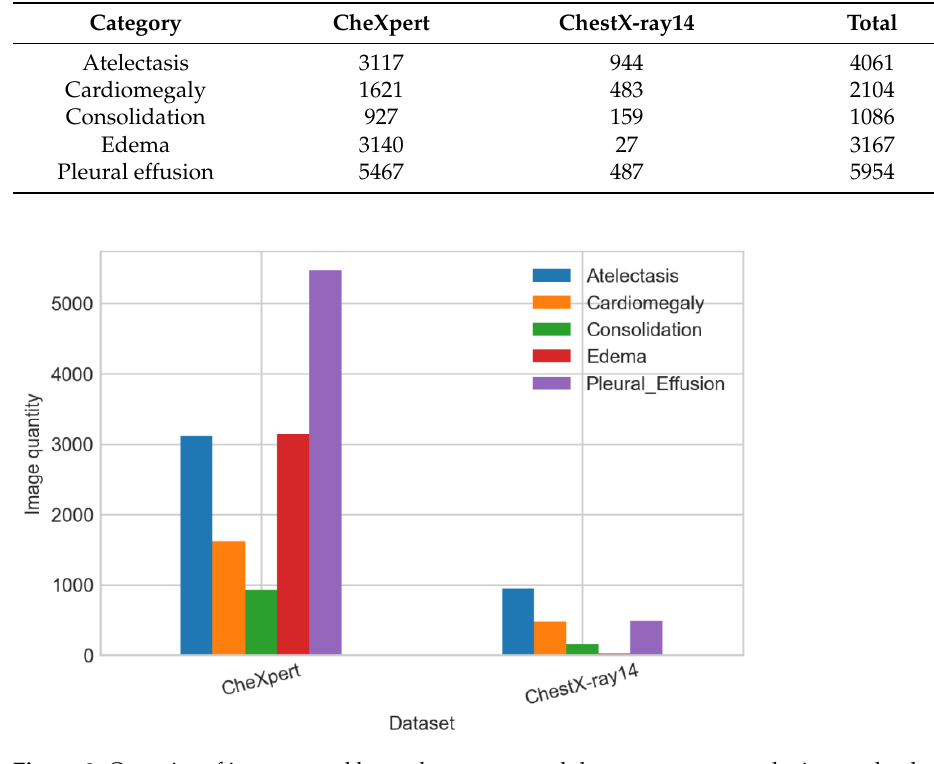
Figure 2. Quantity of images used by each category and dataset to generate the image database.